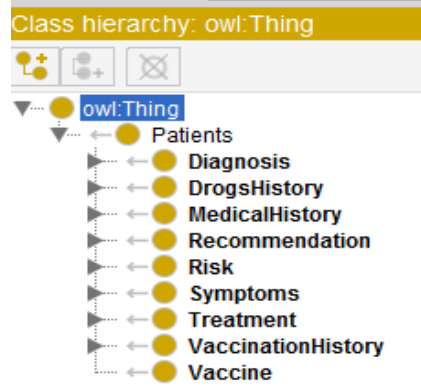
Figure 2. Main class hierarchy of the CODCA ontology. Medical history has a subclass of chronic and non-chronic diseases (See Figure 3). Vaccination history has a subclass of fully vaccinated for people that finished taking their vaccine shots, start vaccination for people that start taking their shots, and not vaccinated subclass for those that don’t take Covid-19 vaccine. Drug history has a subclass of 0-1, 1-3, and over 3 weeks on drugs. Risk has a subclass of high, medium, and low risk (Bhopal et al., 2021) as shown in Table 2. Risk factors are automatically determined according to SWRL rules as we discuss in Section 5. Symptoms have a subclass of common, serious, and no symptoms, those with serious symptoms are usually hospitalized, those with common symptoms observe self-quarantine, and those that show no symptoms are advised to stay home for some days to confirm the situation. The diagnosis class has a subclass of Covid-19 positive, negative, and suspect; traveling to a Covid-19 area. The recommendation class has